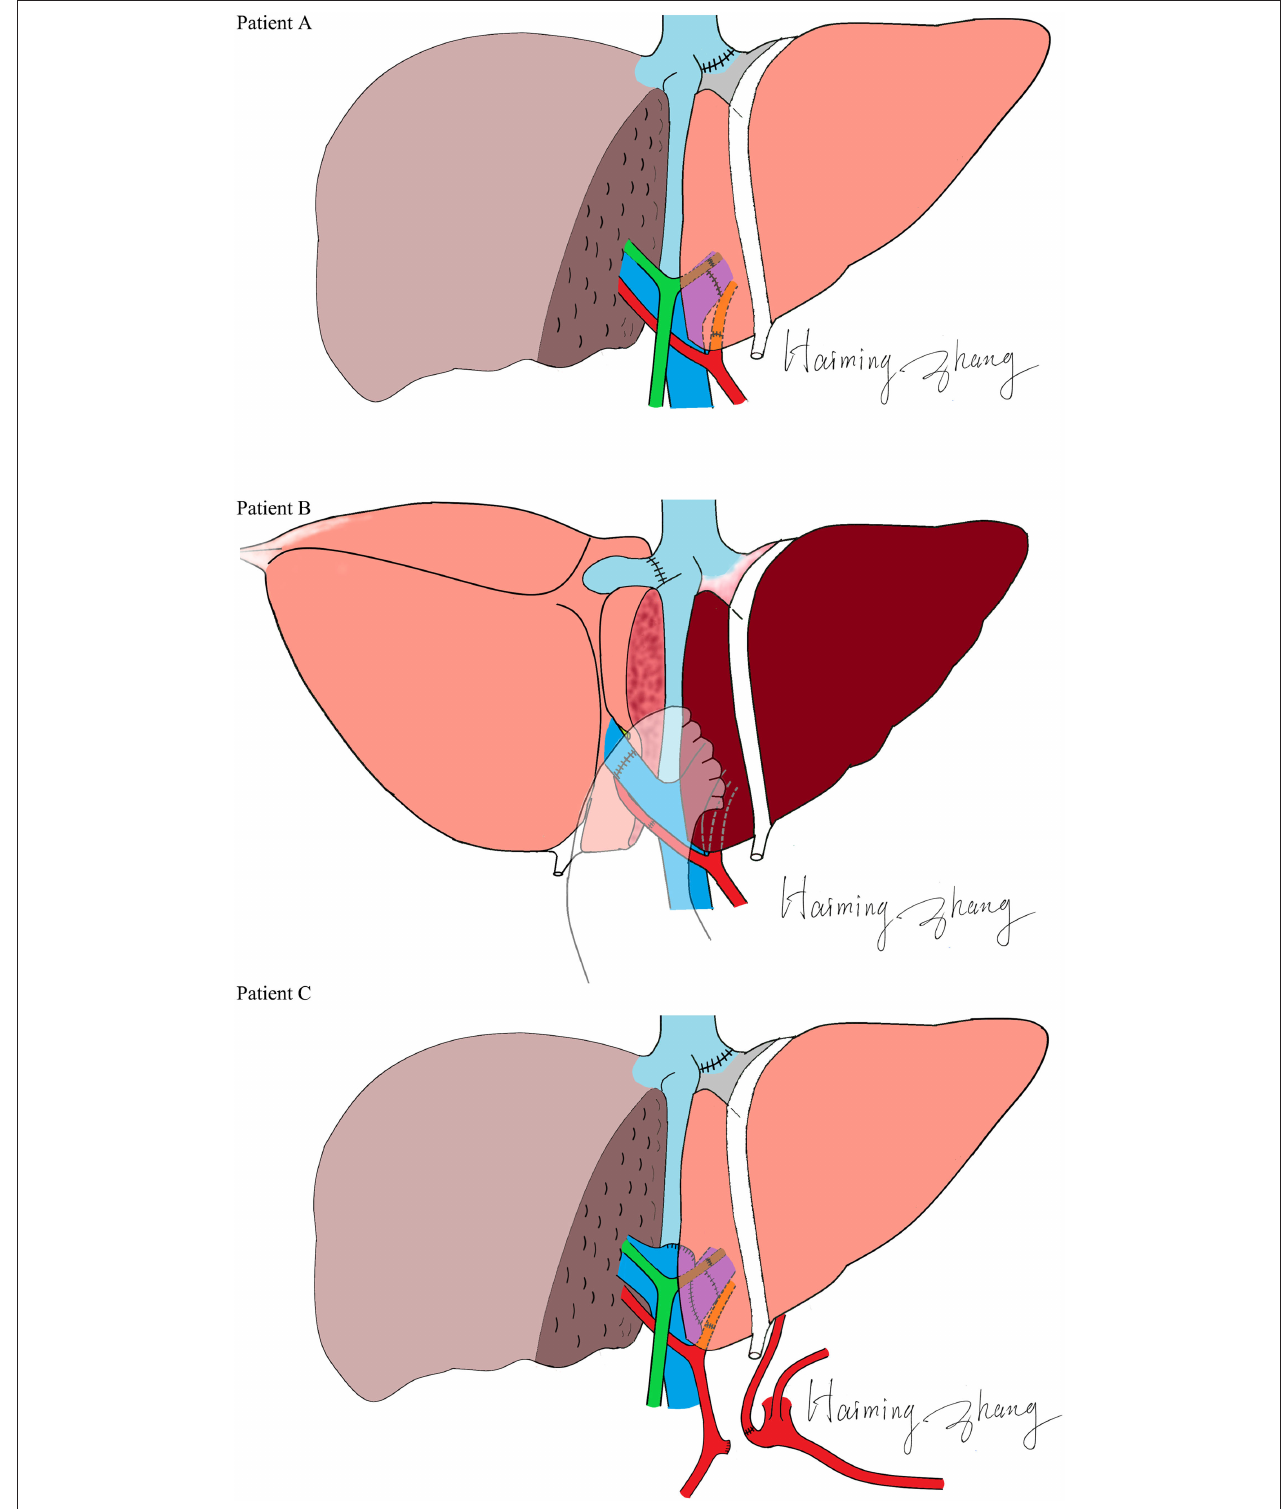
FIGURE 1 | Methods of auxiliary graft